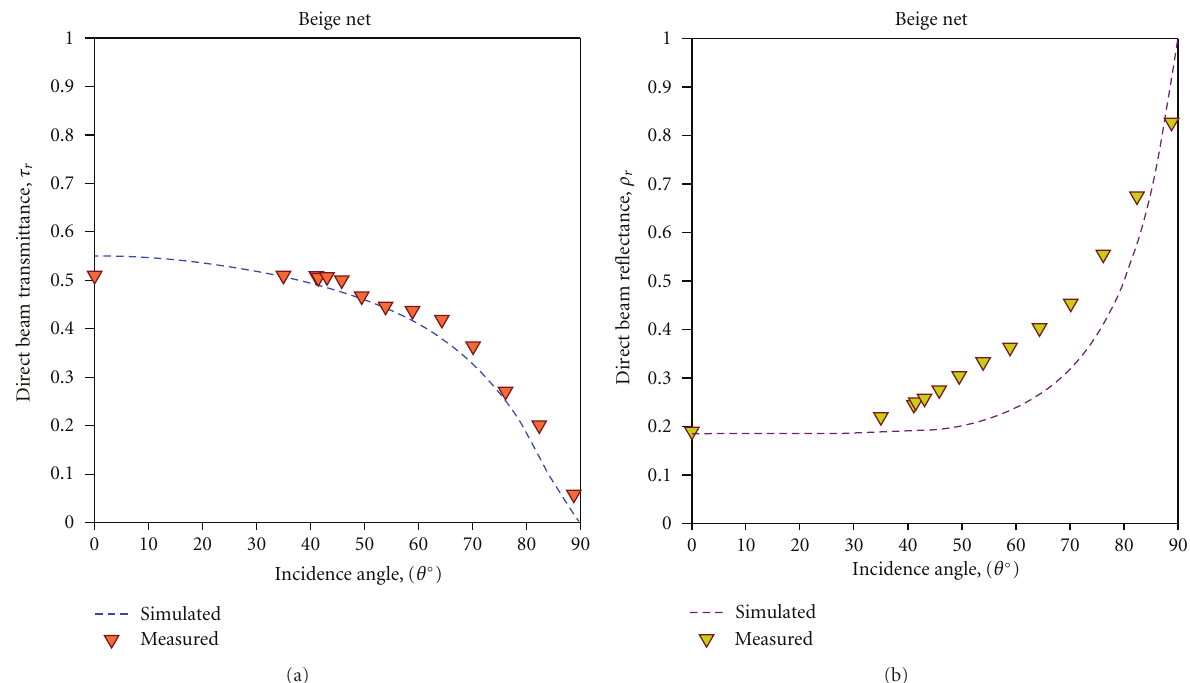
Figure 6: Comparison between the measured [8] and simulated values of (a) the direct beam transmittance ( τ r ) and (b) the direct beam reflectance ( ρ r ) for the beige